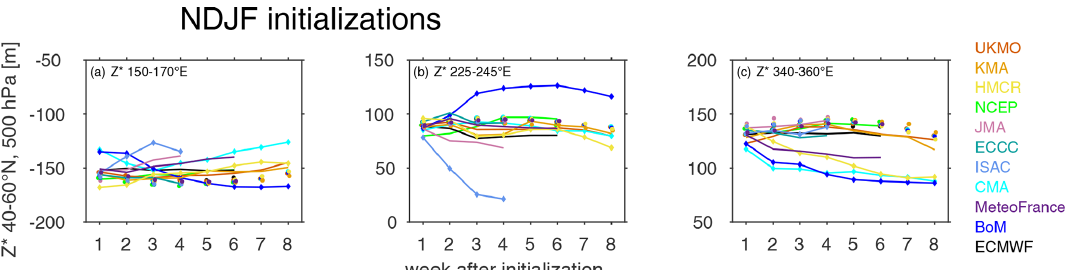
Figure 3. Time evolution of simulated 500hPa stationary eddy height at 40 to 60 ◦ N in three key regions for all models (solid lines) and corresponding days in ERA-I (dots): (a) northwestern Pacific (150–170 ◦ E), (b) western North America (225–245 ◦ E), (c) North Atlantic (340–360 ◦